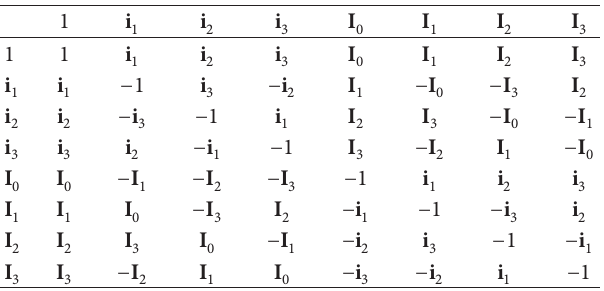
Table 1: The multiplication table of octonion. quaternion, it is able to deduce directly Maxwell’s equations in the classical electromagnetic theory, without the help of the current continuity equation. Similarly some scholars have been applying the complex quaternion to research the gravi- tational theory. A comparison of the two description methods indicates that there are quite a number of sameness between the field theory described by the complex quaternion and the classical field theory described by the vector terminology, except for a little